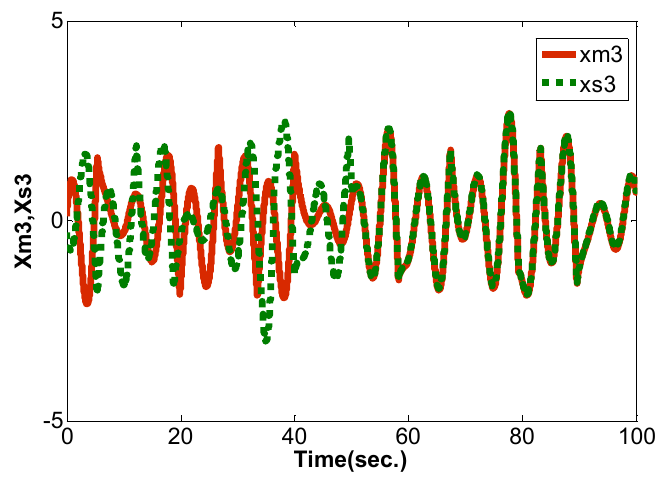
and x synchronization m3 s3